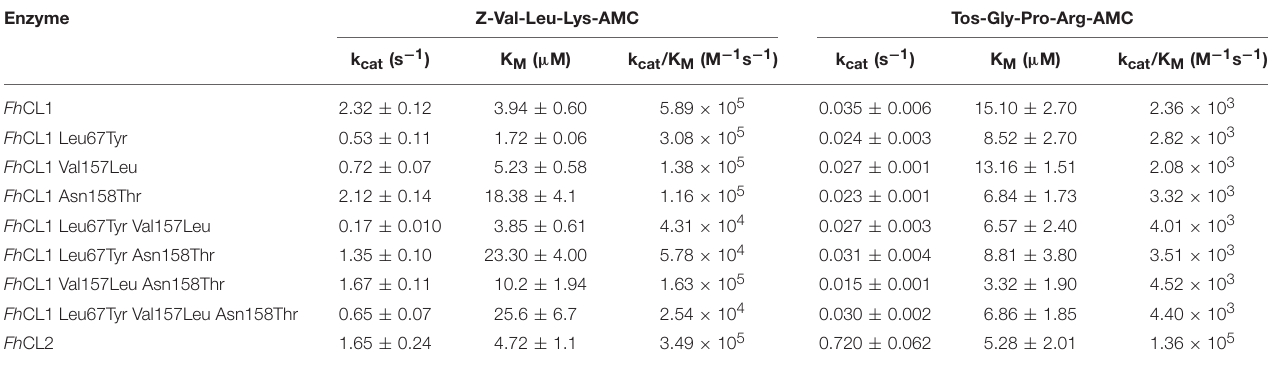
TABLE 2 | Kinetic parameters of Fh CL1, Fh CL2 and the mutant enzymes over two different substrates.